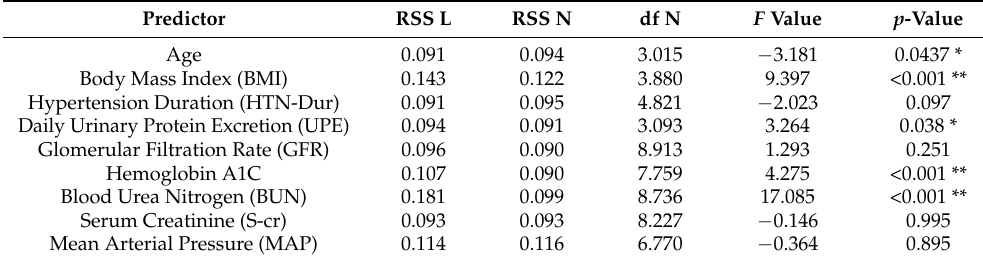
Table 2. The linear effect vs. nonlinear effect of each predictor in the presence of other predictors; columns (1)–(6) refer to predictors, Residual Some of Squares Linear (RSS L), Residual Some of Squares nonlinear (RSS N), degrees of freedom Nonlinear (df N), F value, and p -Value; ** significant at 0.001, * significant at 0.05. Predictor RSS L RSS N df N F Value p